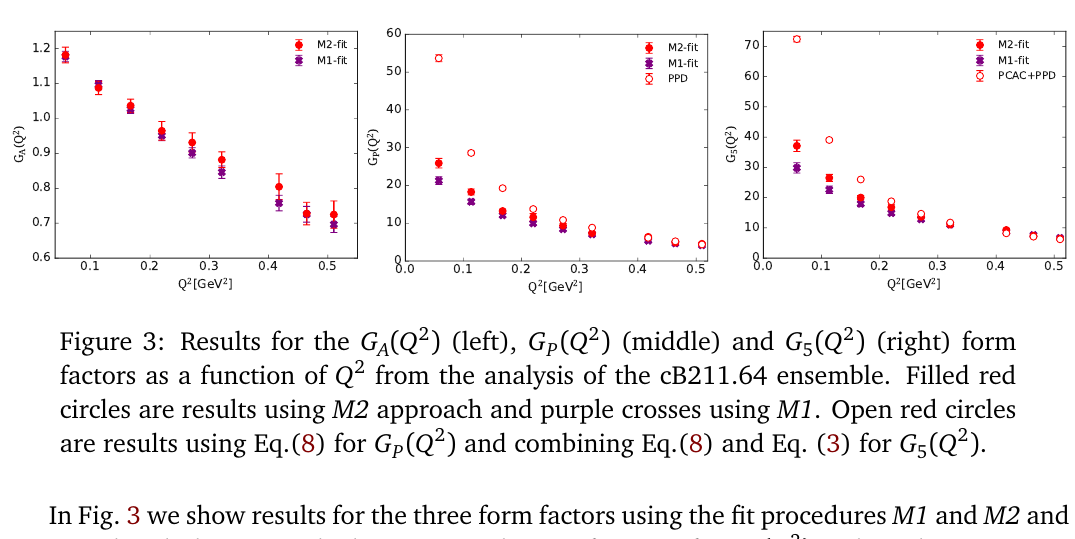
Figure 3: Results for the G factors as a function of Q 2 from the analysis of the cB211.64 ensemble. Filled red circles are results using M2 approach and purple crosses using M1 . Open red circles are results using Eq.(8) for G